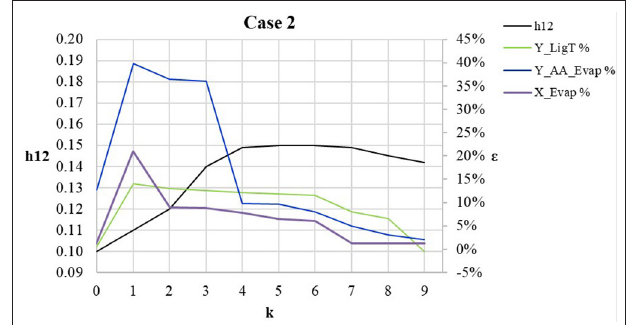
FIGURE 5 | Error vs. iteration—case 2.